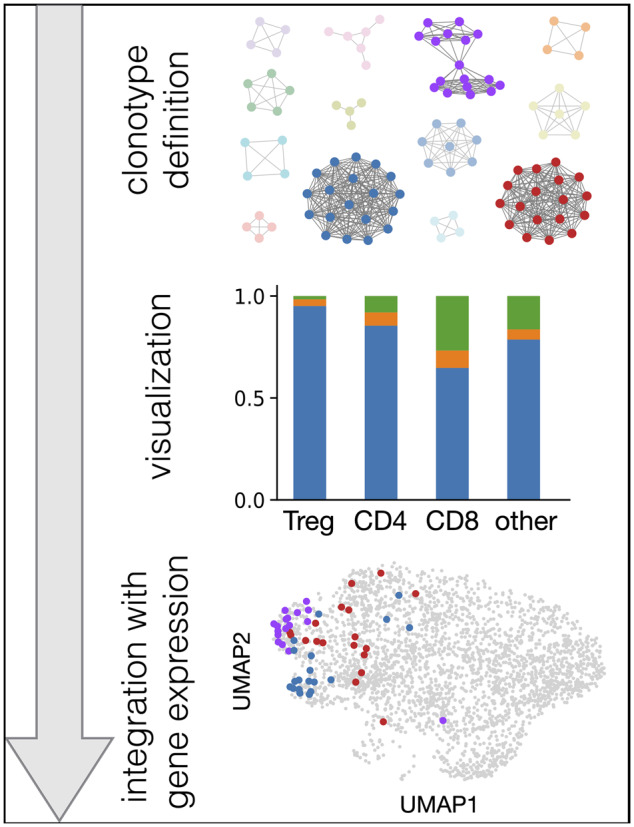
Schematization of the Scirpy workflow. Definition of clonotype networks (top panel), clonotype analysis and visualization (e.g. clonal expansion of T-cell subpopulations, middle panel), and integration with gene expression data (e.g. UMAP plot, bottom panel)